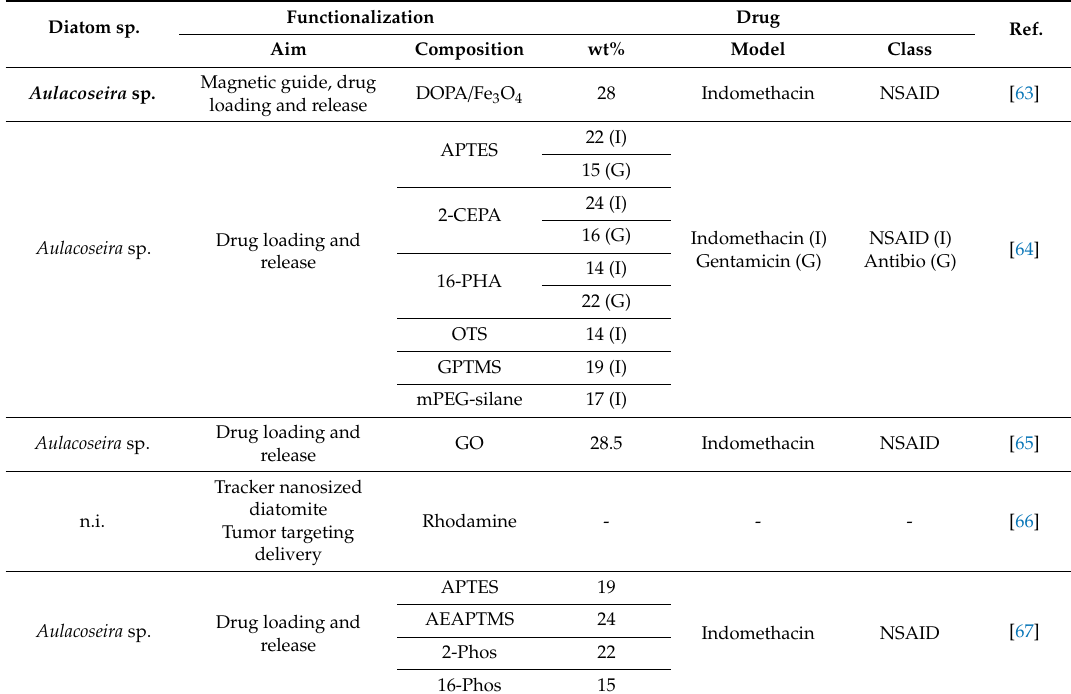
Figure 5. Overview of the potential surface modification of diatoms used in pharmaceutical applications. NP: nanoparticles. Small interfering RNA (siRNA); Vitamin B 12 (B 12 ); Iron oxide nanoparticles (Iron ox. NPs); Fluorescent dye (Fluo. dye); Photoluminescent compound (PL); Carbon monoxide-releasing molecules (CORMs); Nitric oxide releasing molecules (NORMs); Scavengers of reactive oxygen species (ROS scav.). Table 1. Di ff erent diatomite functionalizations and drug-loading (DL) capacities in drug delivery